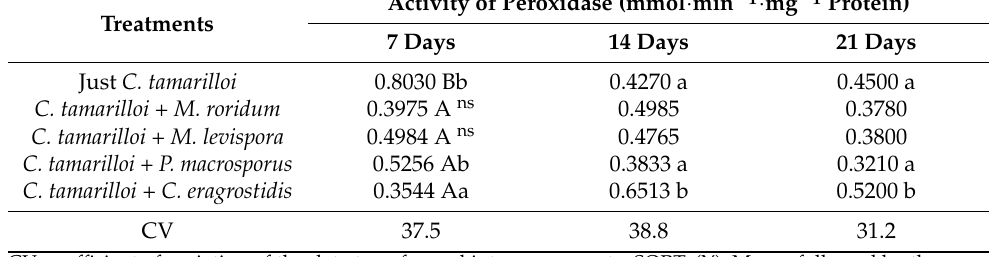
Table 5. Activity of the enzyme peroxidase in rubber tree seedlings after curative treatments with saprobic fungi.